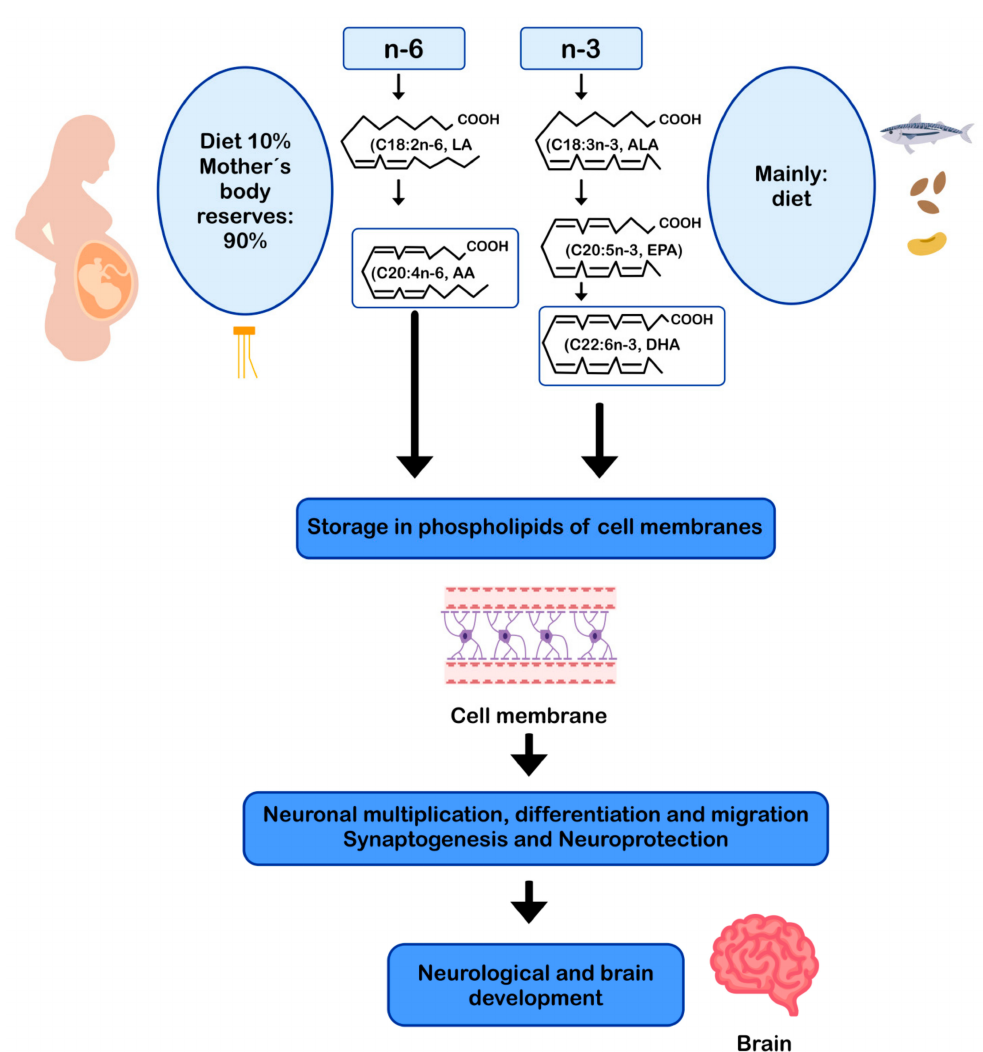
Figure 2. AA and DHA in neuronal development and function. AA: arachidonic acid; ALA: alpha-linolenic acid; DHA: docosahexaenoic acid; EPA: eicosapentaenoic acid; LA: linoleic